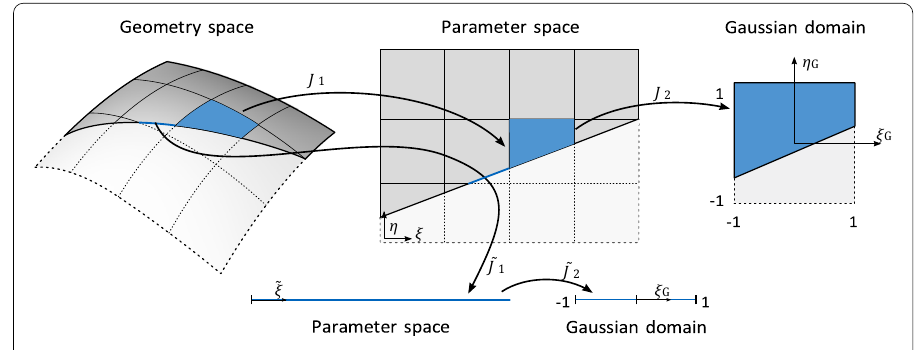
Fig. 3 Mapping operations between Geometryspace and Integrationdomain for the surface and a trimming curve, respectively (modified from [18])